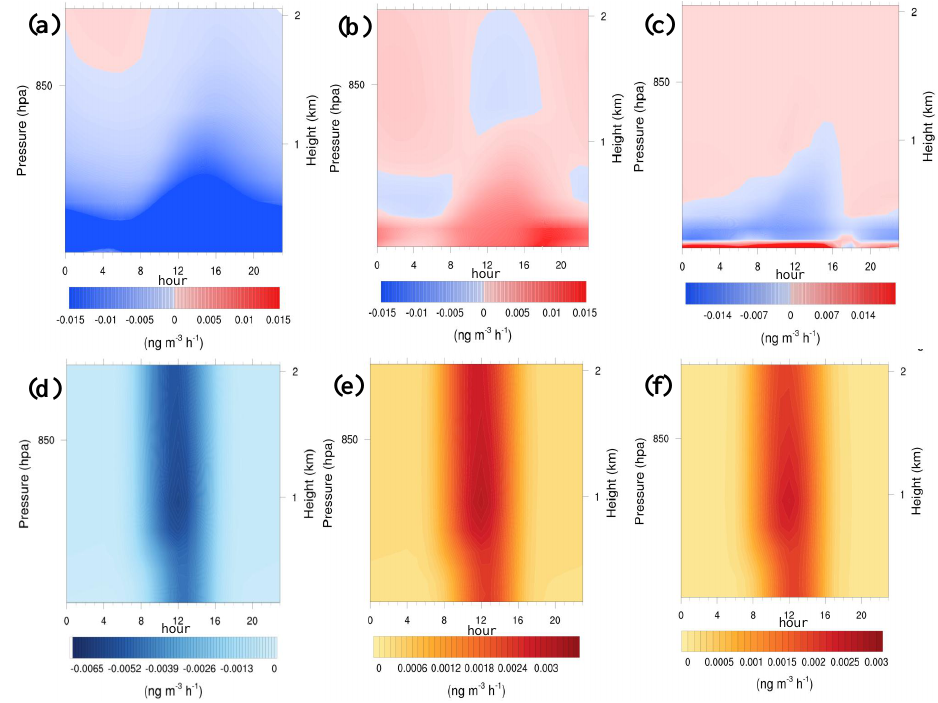
Figure 7. Profile of the contribution of (a) HADV to GOM in urban areas and (b) HADV to GOM, (c) VDIF to GOM, (d) CHEM to GEM, (e) CHEM to GOM and (f) AERO to PBM in non-urban